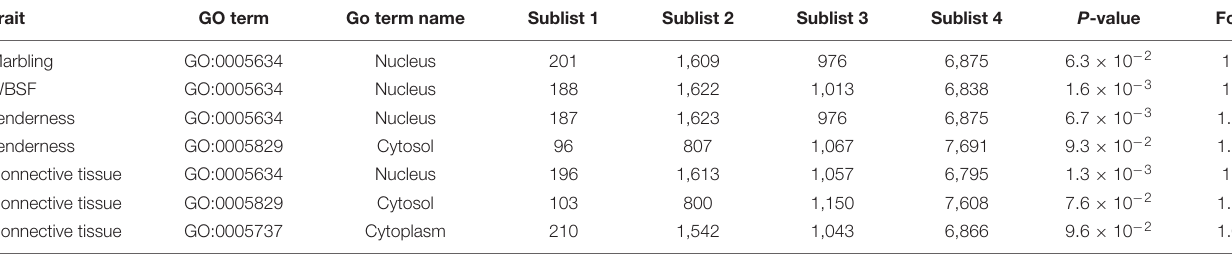
TABLE 2 | Pathways identified as enriched for WBSF, tenderness, connective tissue and marbling.